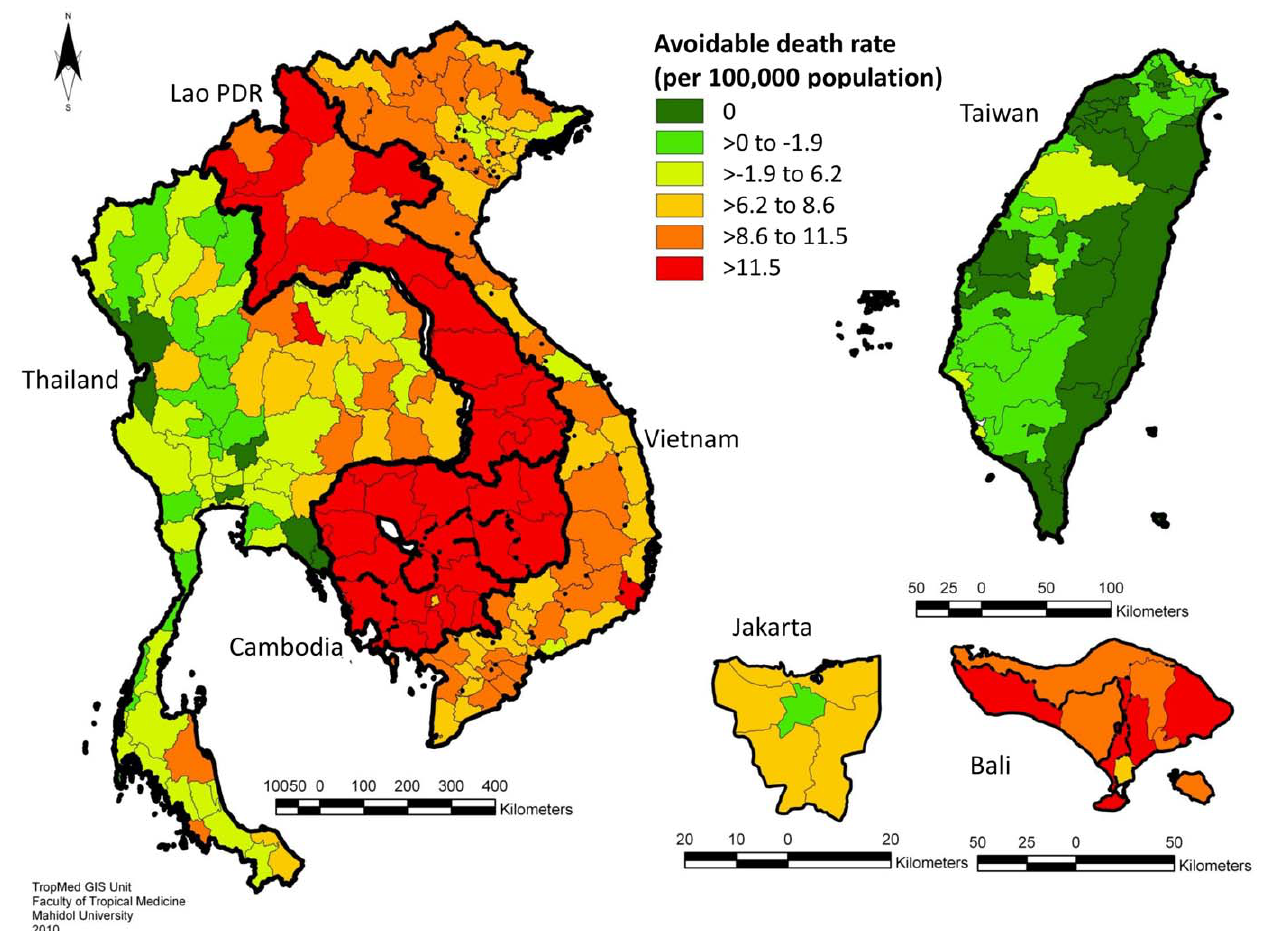
Figure 2. Geographical distribution of estimated avoidable mortality rates due to resource gaps for a modeled pandemic influenza scenario. Values are mapped at province level for Cambodia, Lao PDR, Thailand and Vietnam, at county level for Taiwan, and at district level for Jakarta and Bali in Indonesia.